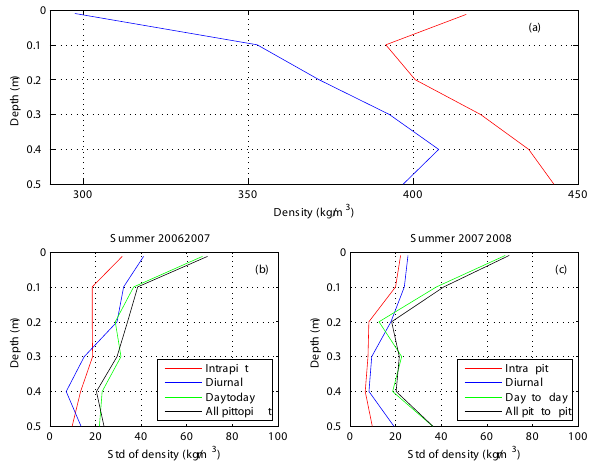
Fig. 6. Small-scale snow density observations near Basen nunatak: vertical profiles of (a) mean snow density in summers 2006– 2007 (red) and 2007–2008 (blue), (b) standard deviation of snow density at different scales in summer 2006–2007, and (c) summer 2007–2008.